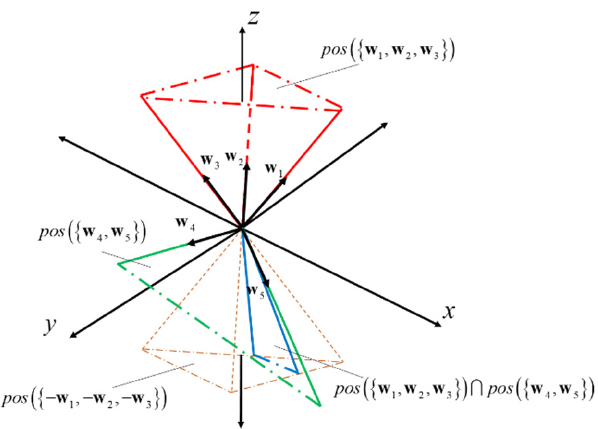
Figure 3. Specific case of a certain 2-redundant actuators-planar CDPM when general coordinate of moving platform presented in the wrench-closure workspace.